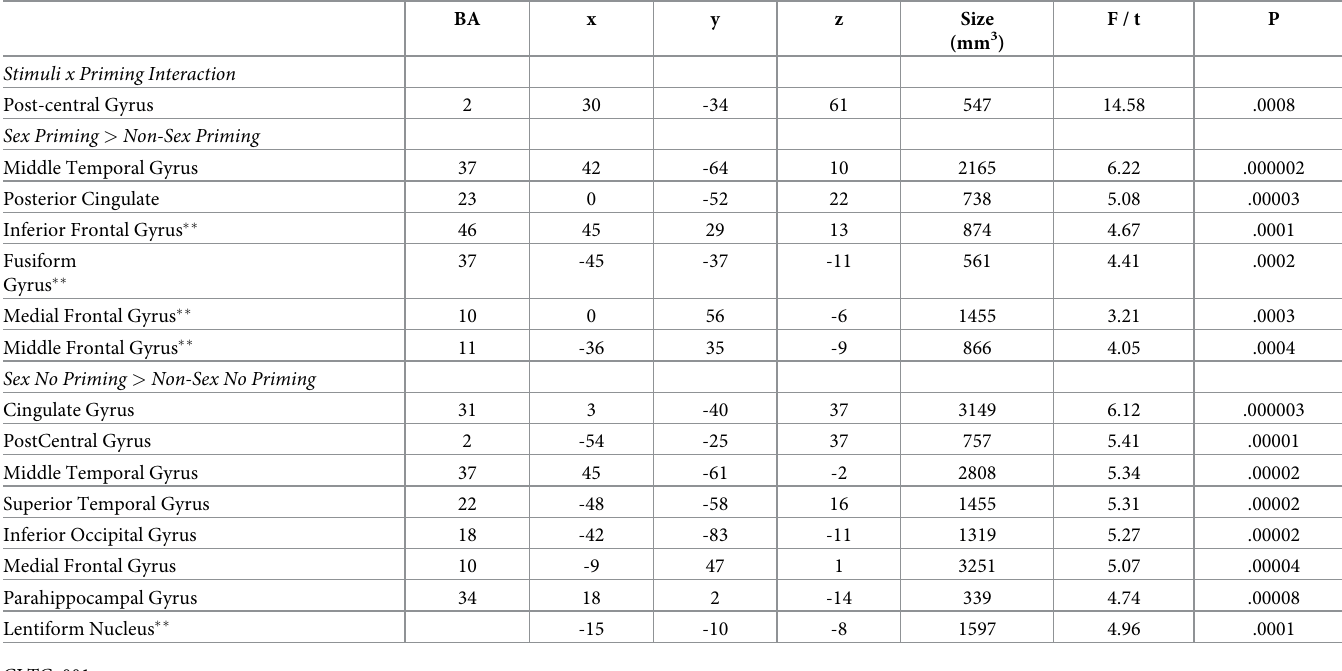
Table 3. Cognitive sexual inhibition—Negative affective priming